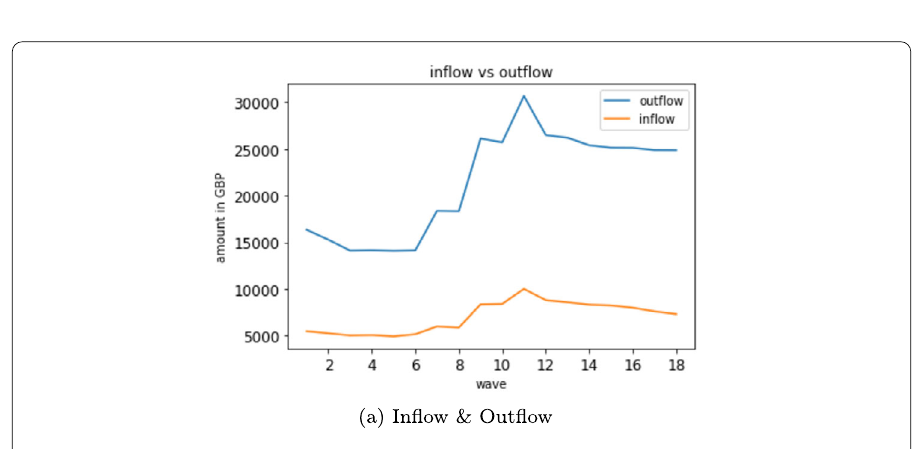
Figure 9 UK Inflow Outflow Plot of our Simple Pension System reflecting inflow of pension savings(assuming savings rate of 0.0775) from contributors who are still in workforce, and outflow of funds to pensioners(assuming weekly pension of